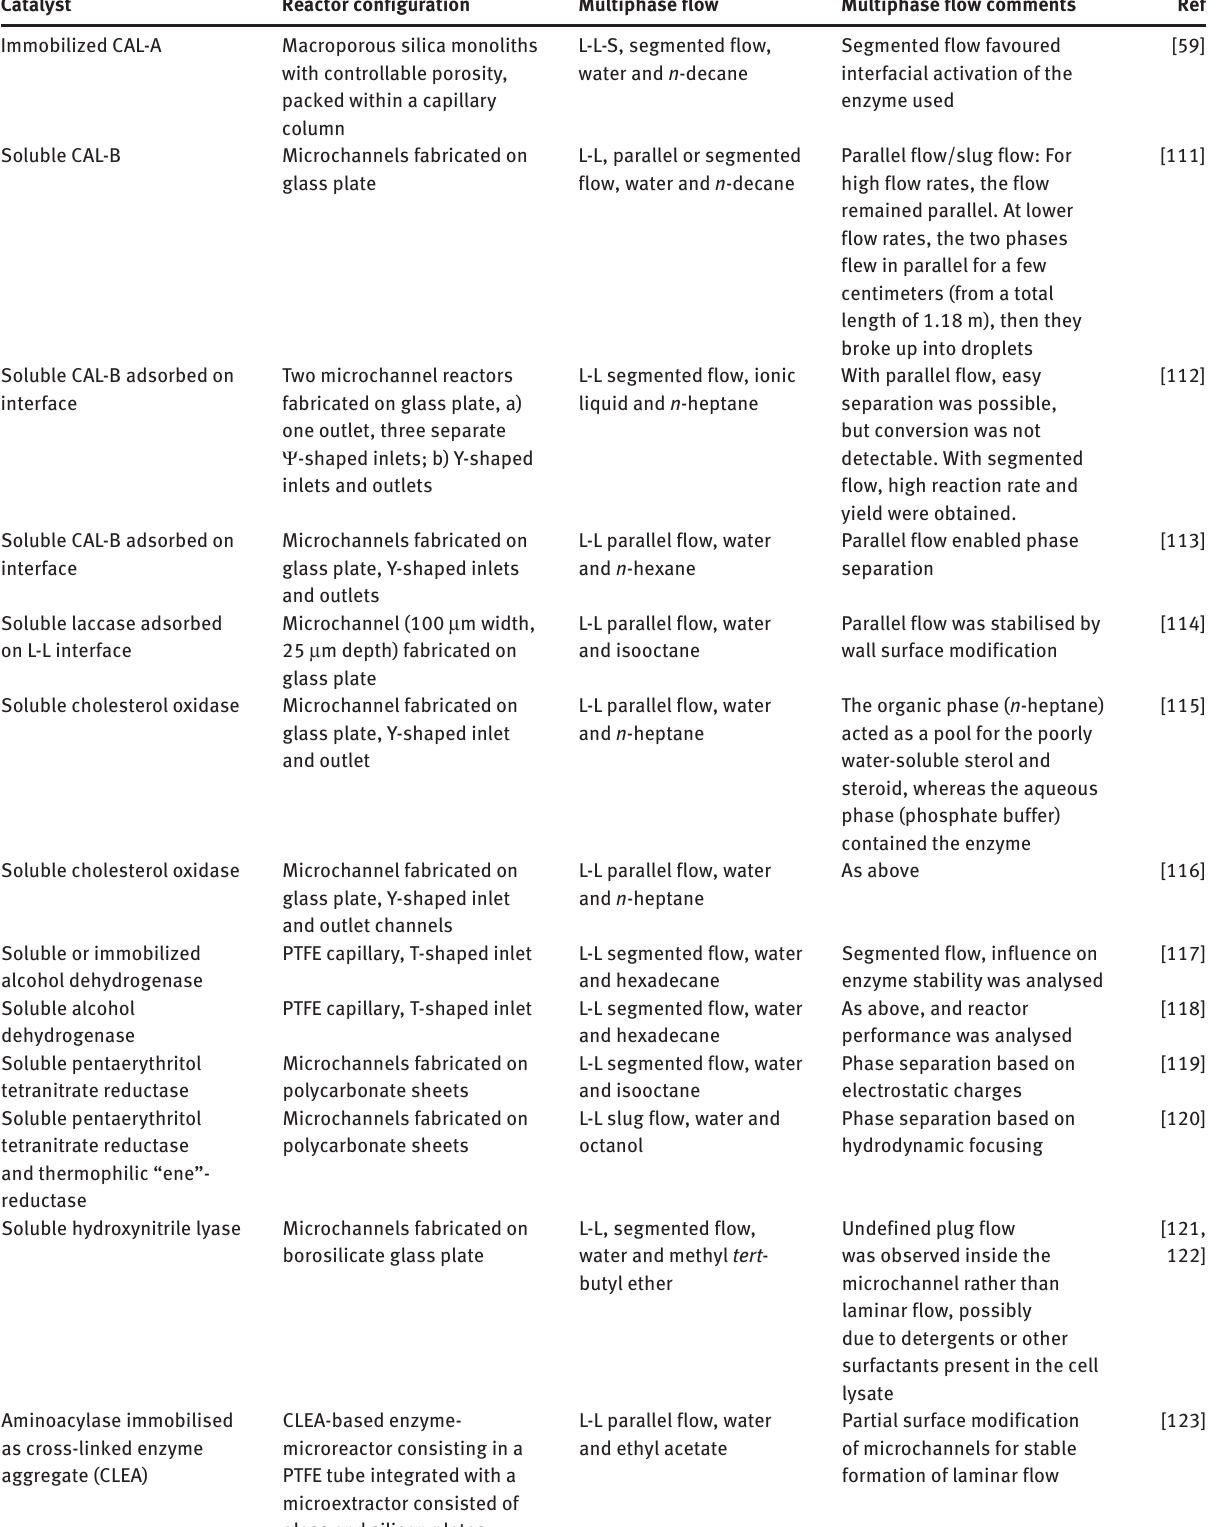
Table 1 Biotransformation studies under multiphase flow conditions in microstructured reactors.